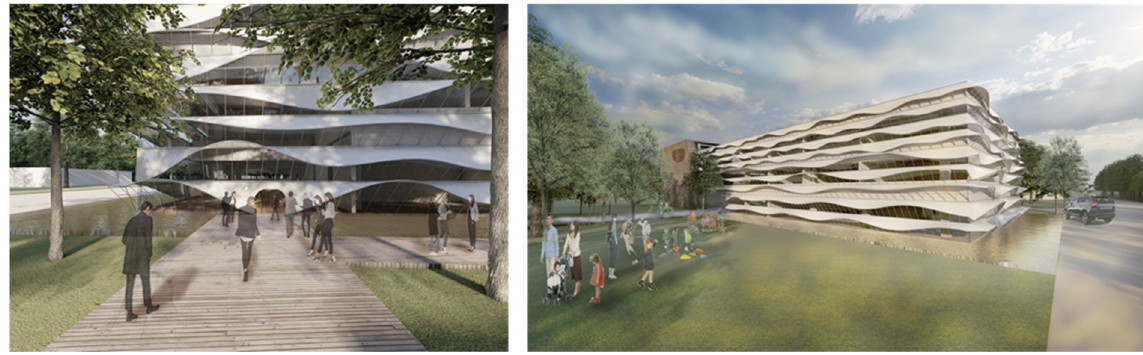
Figure 9. The final decision façade of headquarters (Participant C).